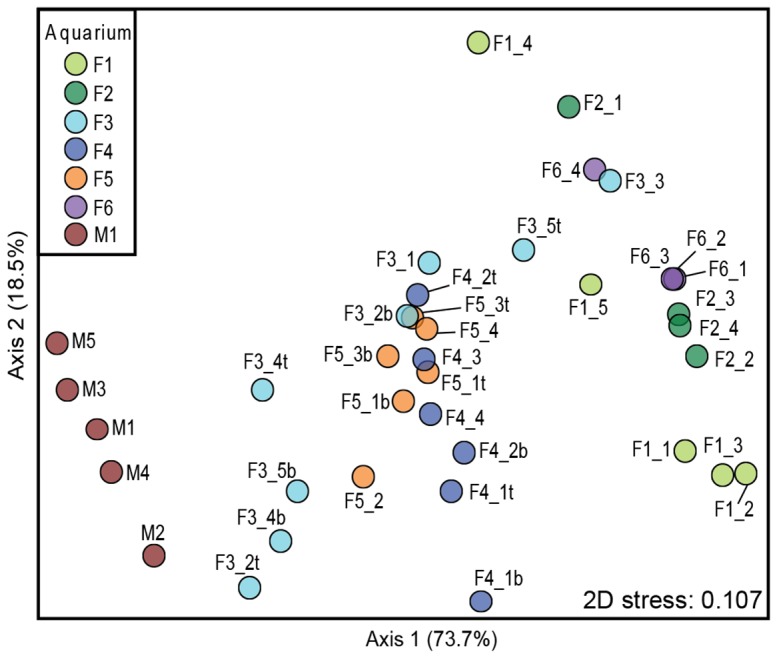
Nonmetric multidimensional scaling (NMDS) ordination of thaumarchaeal 16S rRNA gene DGGE fingerprint.The two-dimensional stress value for the NMDS was 0.107 based on Bray Curtis distance. Coefficients of determination (R
2) on each axis represent correlations between ordination distances and the corresponding distance matrix.